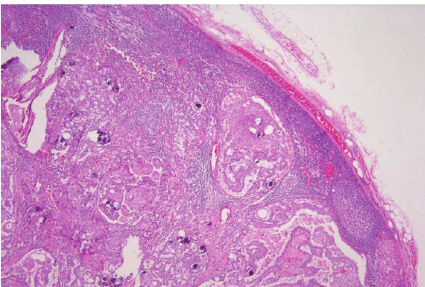
Figure 5: The lymph nodes exhibit metastatic papillary carcinoma of the classical configuration, with characteristic nuclei, and numer- ous microcalcifications (Hematoxylin & Eosin stain ×